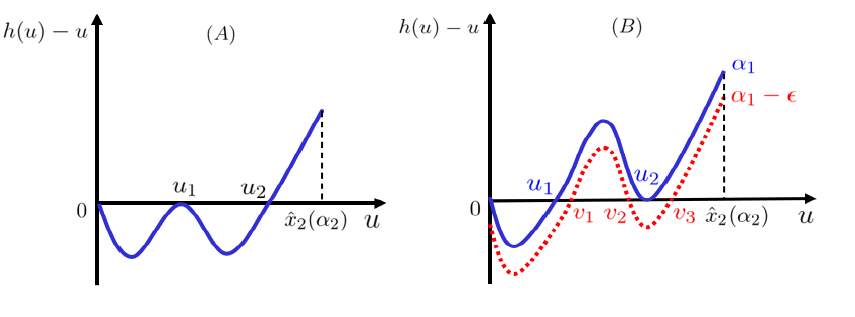
Figure 2. The situations for models (4) and (5) with two periodic solutions. Panel ( A ) is for the